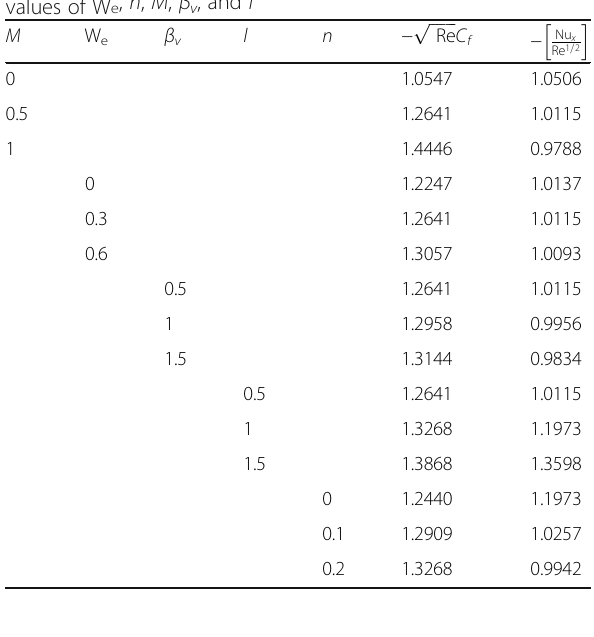
Table 3 Numerical values of − values of W e , n , M , β v , and